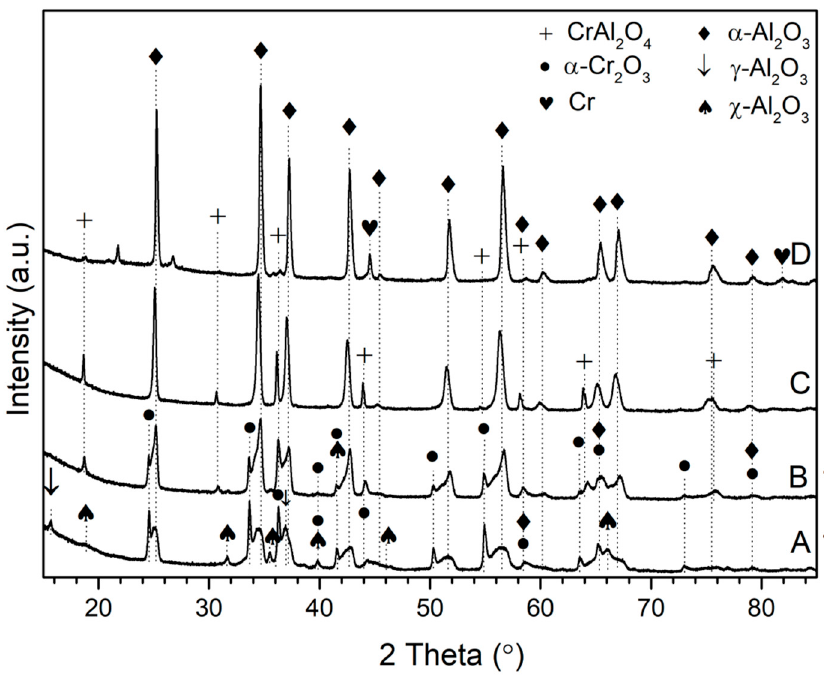
Figure 2. XRD patterns of the sample after reduction at 1000 ( A ), 1150 ( B ), 1300 ( C ), and 1450 ( D ) °C.